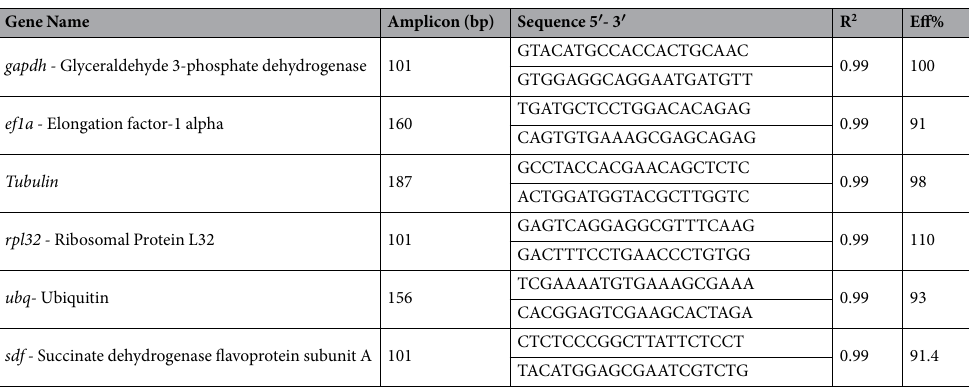
Table 3. Primers used in identification of reference genes. R 2 : Correlation Coefficients; Eff: Amplification